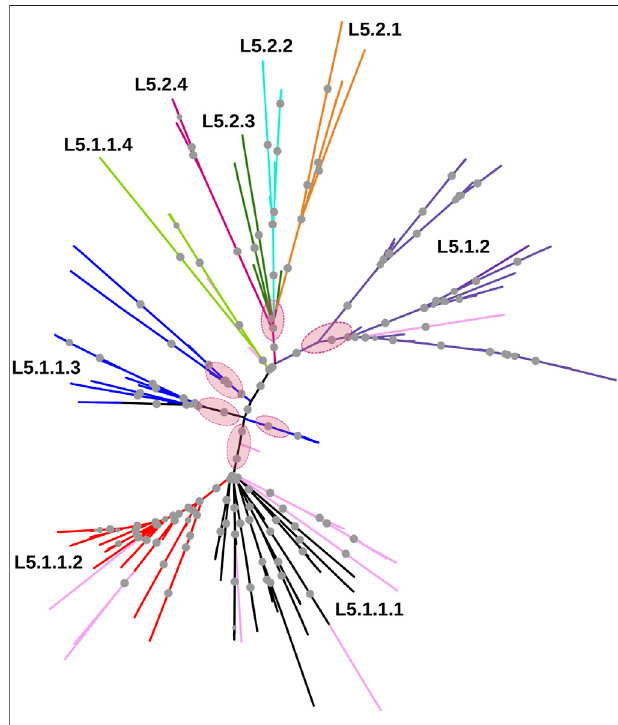
FIGURE 3 | Phylogenetic tree of Mycobacterium africanum L6 samples derived using the maximum likelihood method, as implemented in RAxML based on genome-wide SNPs. Signi fi cant bootstrap values > 70% are represented by solid gray circles.